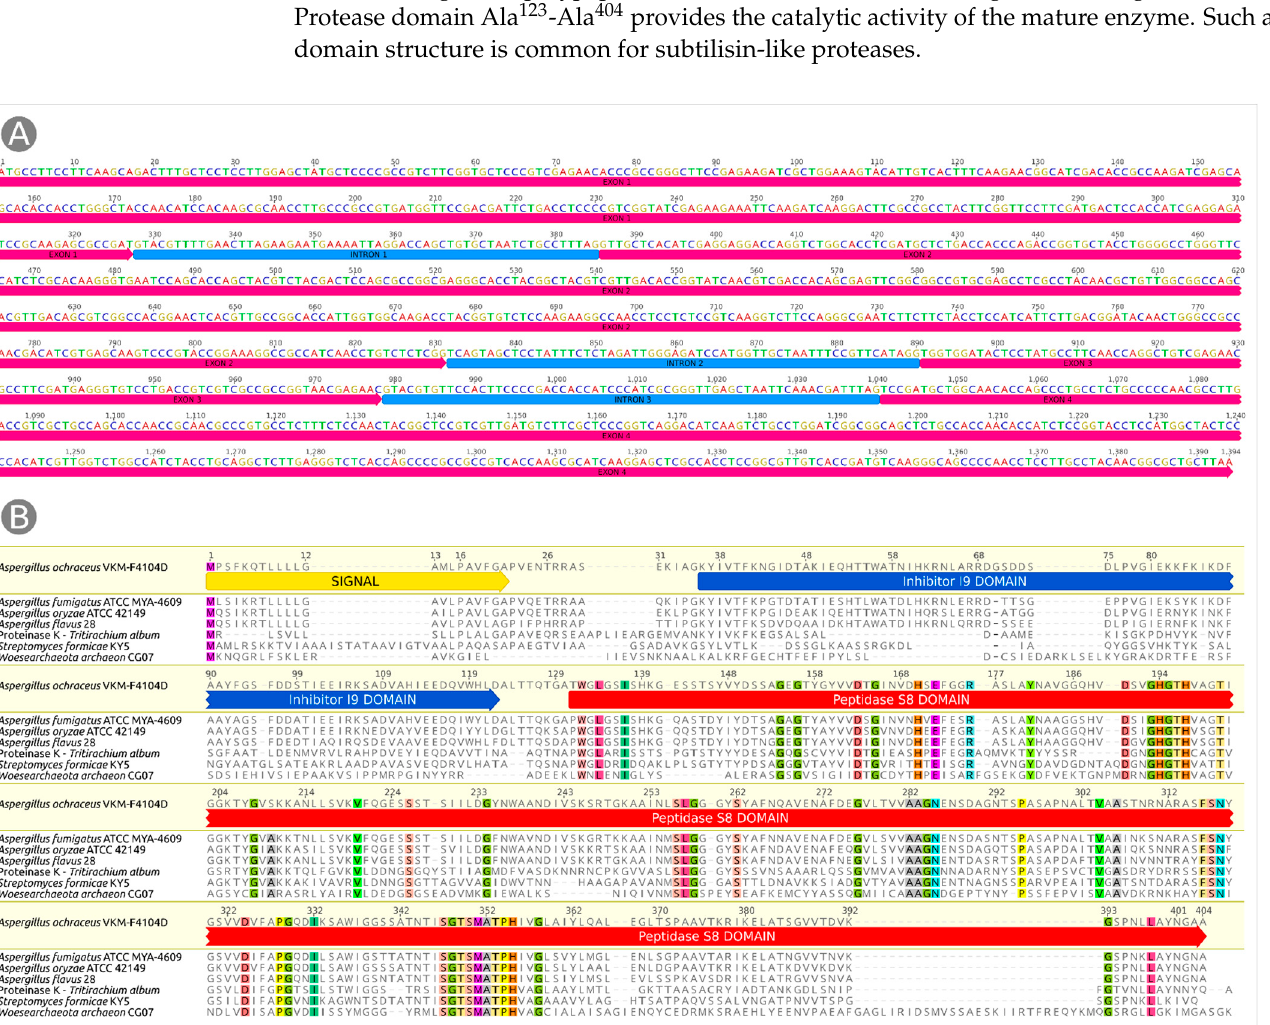
Figure 1. ( A )The gene of Aspergillus ochraceus VKM-F4104D alkaline protease. Exons are coloured crimson and introns are coloured blue. ( B )The protein sequence of Aspergillus ochraceus VKM-F4104D alkaline protease (upper row) aligned with subtilase sequences from different organisms of various species. Conservative amino acid residues are highlighted with colours. Signal peptide region (yellow strip), inhibitor I9 domain (blue strip) and peptidase S8 domain (red strip) are annotated on the basis of bioinformatic analysis and experimentally found corresponding regions in Aspergillus fumigatus ATCC MYA-4609, Aspergillus oryzae ATCC 42,149, and Aspergillus flavus 28 homologs.